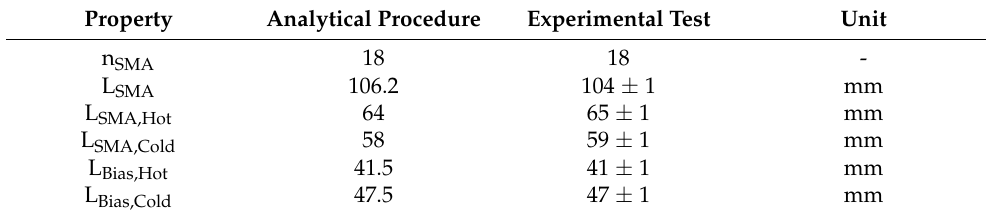
Table 7. Comparison between the geometric characteristics of bias and SMA spring obtained from the analytical procedure and experimentally